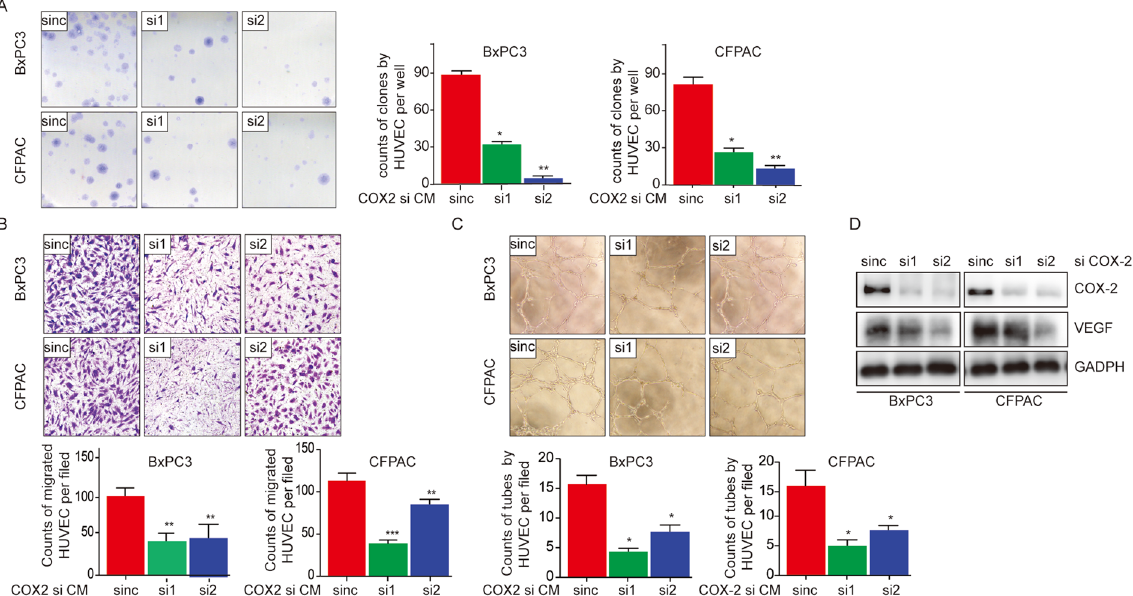
Figure 4. Elevated COX-2 contributes to angiogenesis in a process dependent on VEGF. ( A ) The clones formed by HUVECs when cultured in the conditioned media from COX-2 knockout cells. ( B ) The counts of migrated HUVECs when cultured in the conditioned media of COX-2 knockout cells. ( C ) The tubes formed by HUVECs when cultured in the conditioned media from COX-2 knockout cells. ( D ) VEGF expression in COX-2 knockout PDAC cells.